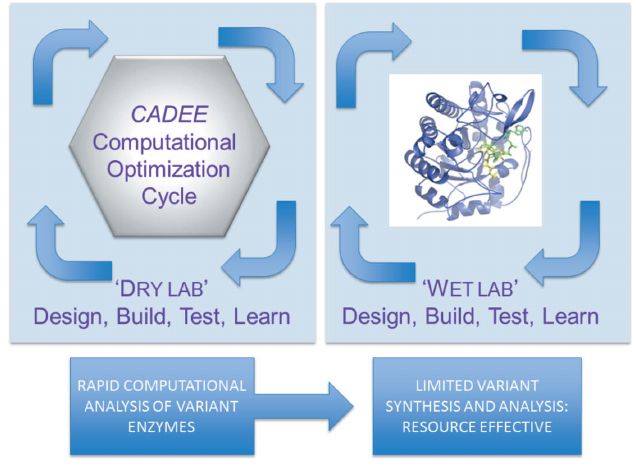
Figure 1 CADEE and Design, Build, Test, Learn iterative cycles. CADEE and other predictive computational tools in the enzyme engineering ‘dry lab’ lessens burden on resources and experimental effort in the design, build, test and learn cycles of the ’wet